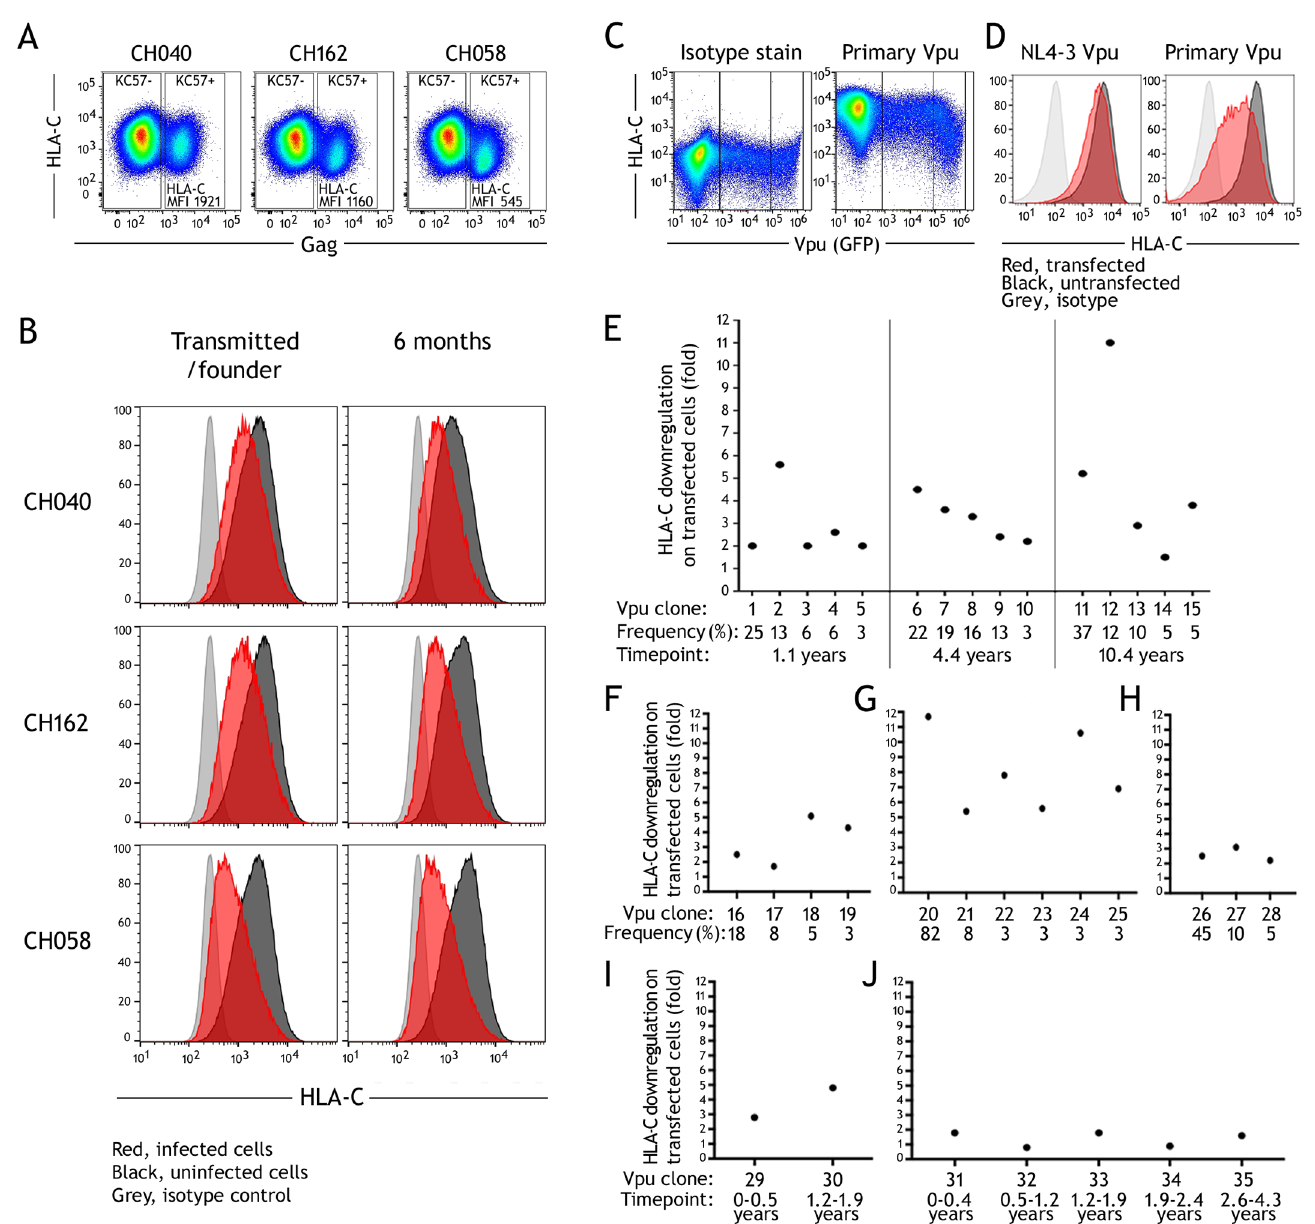
Fig 2. HLA-C downregulation in untreated HIV-1 infection. (A) Infectious molecular clones were assessed for ability to downregulate HLA-C for 3 individuals: CH040, 162, 058. Representative staining is shown for primary CD4+ cells infected in vitro, with HLA-C staining compared between infected and uninfected cells within a culture. (B) For the 3 individuals infectious molecular clones of both transmitted/founder viruses and those 6 months after infection were tested. HLA-C staining is shown for infected (red) and uninfected cells (black) compared to an isotype control stain (grey). (C) For ART-naïve individuals multiple cloned Vpu molecules were measured for ability to downregulate HLA-C by transfection of HeLa cells, with transfected cells in a culture identified by co-transfection of a GFP expression plasmid. (D) Staining for HLA-C is shown for Vpu clones with differential downregulation, showing transfected (red) and untransfected cells (black) compared to an isotype control (grey). (E) HLA-C downregulation is shown for 15 Vpu clones from one individual sampled at 3 timepoints over 10 years. (F-H) HLA-C downregulation observed for multiple clones from a single timepoint for 3 individuals. (I,J) HLA-C downregulation observed for dominant Vpu clones from longitudinal timepoints for 2